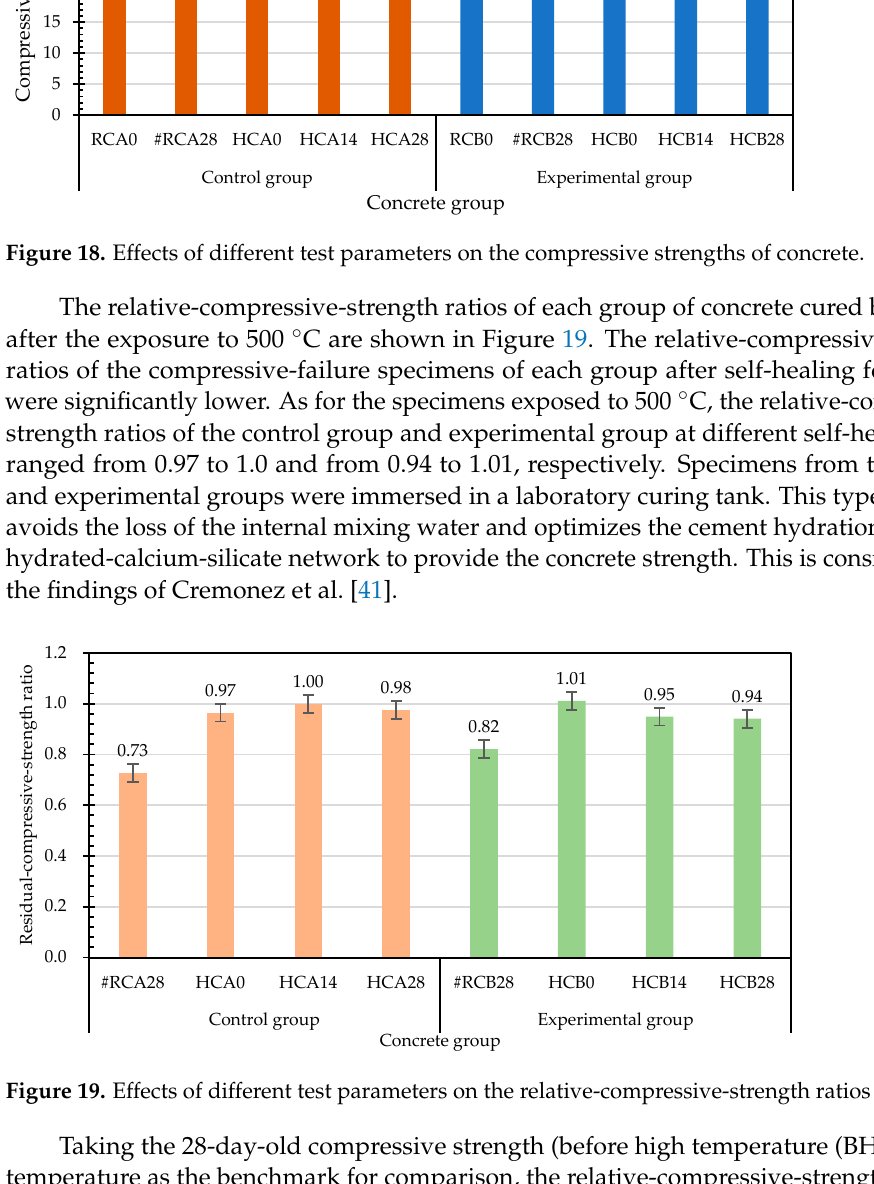
each group of concrete at different self-healing ages are shown in Figure 20. The residual